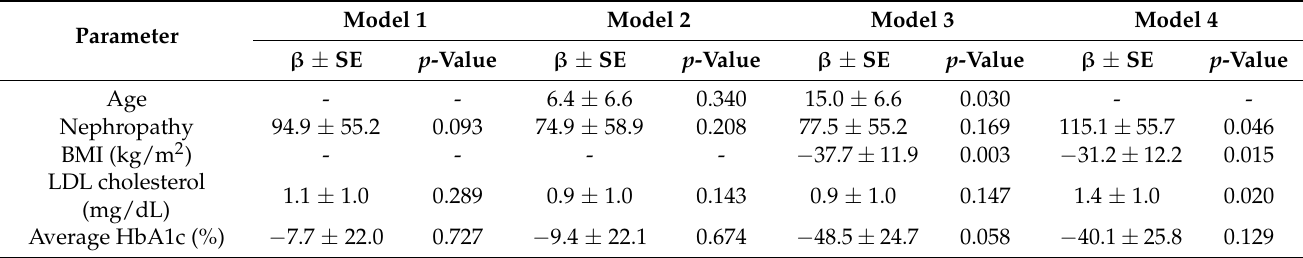
Figure 3. Boxplot of testosterone levels according to baseline characteristics. (a) Type 1 diabetes with nephropathy; (b) type 1 diabetes without nephropathy; and (c) control group. Multiple linear regression analysis was performed to determine the relationship between total testosterone levels and nephropathy after adjusting for confounding factors. Nephropathy in patients with T1D did not show a significant relationship with testosterone levels after adjustment for age, BMI, LDL cholesterol levels, and HbA1c levels ( p = 0.169) (Table 3). Table 3. Multiple linear regression analysis of testosterone levels according to the presence of nephropathy.